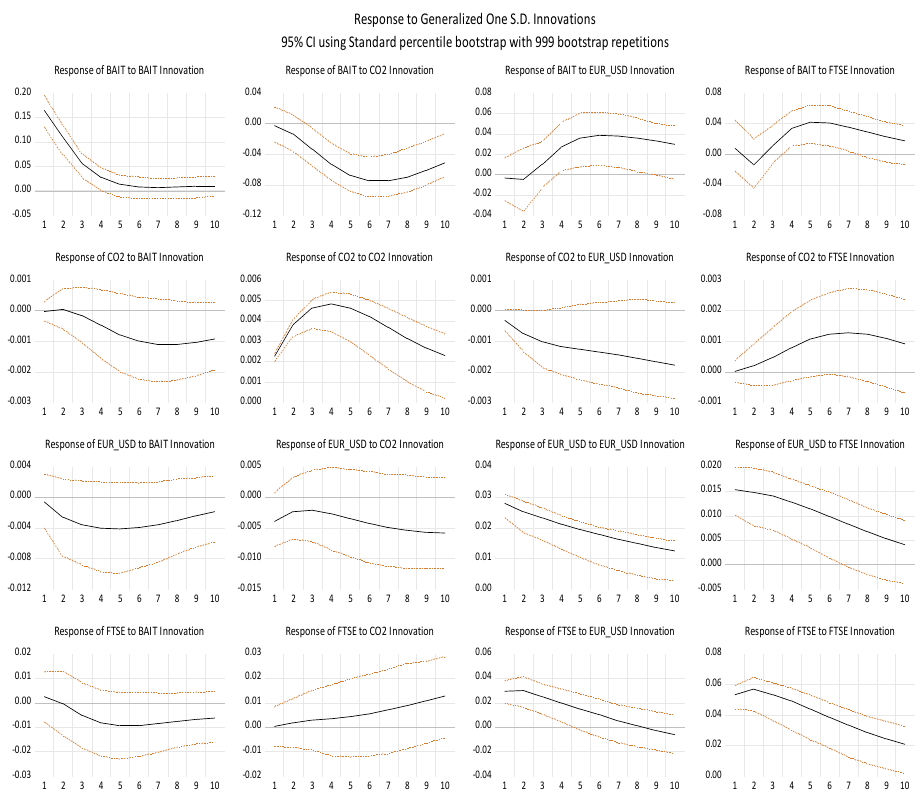
Figure 2. Impulse Response Analysis of the model variables for a ten − period time horizon.